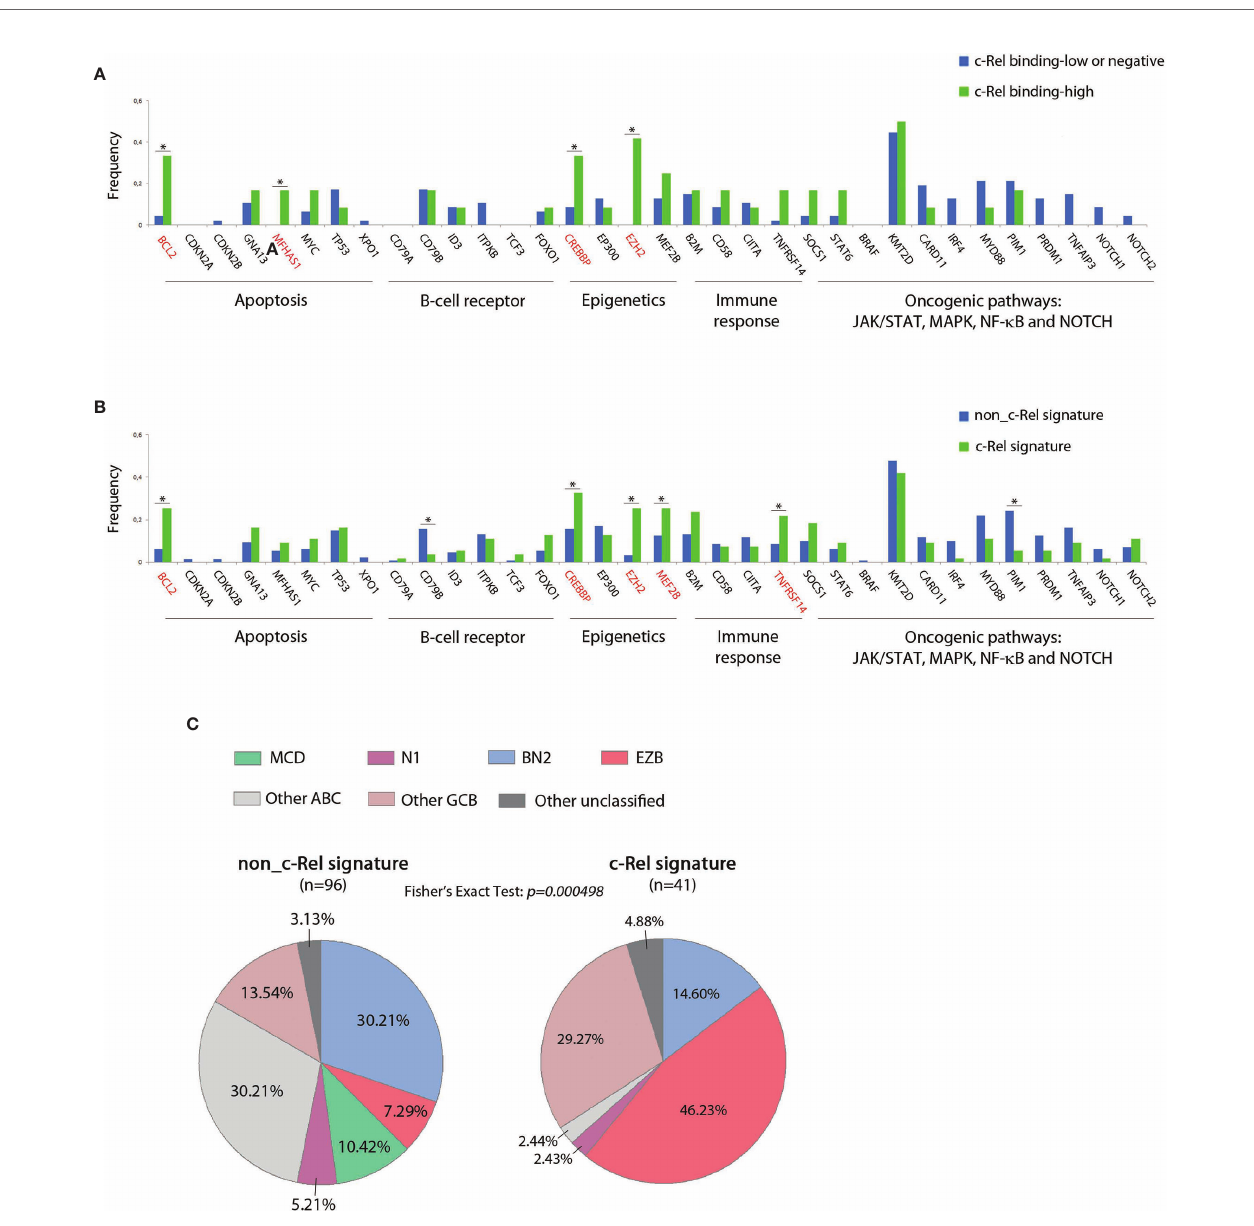
FIGURE 5 | c-Rel related oncogenic mutations in DLBCL patients from the GHEDI cohort. (A, B) Mutation frequencies of 66 cases analyzed by EMSA according to c-Rel DNA-binding activity and the whole GHEDI series according to c-Rel expression signature. Genes known to be mutated at high frequencies in GCB DLBCLs are highlighted in red. The functional pathways are indicated at the bottom of the graph. *: Fisher exact test p-value < 0.05 . (C) Percentage of 134 DLBCL cases that could be reclassi fi ed in BN2 (based on BCL6 fusions and NOTCH2 mutations), EZB (based on EZH2 mutations and BCL2 translocations), MCD (based on MYD88L265P and CD79B ), N1 (based on NOTCH1 mutations), “ other ABC ” , “ other GCB ” , and “ other unclassi fi ed ” subtypes according to the c-Rel expression